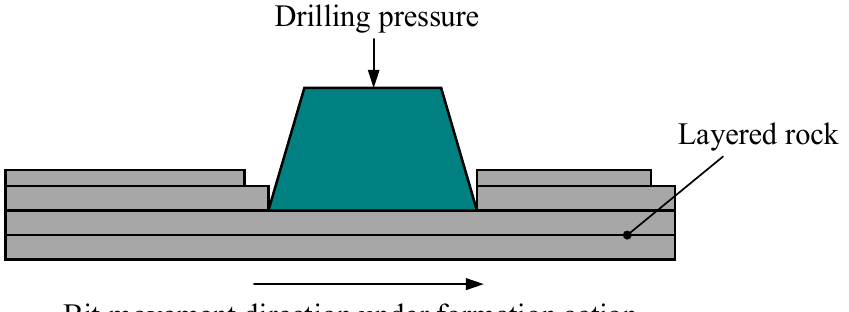
Figure 12. Schematic diagram of bit working in layered formation.